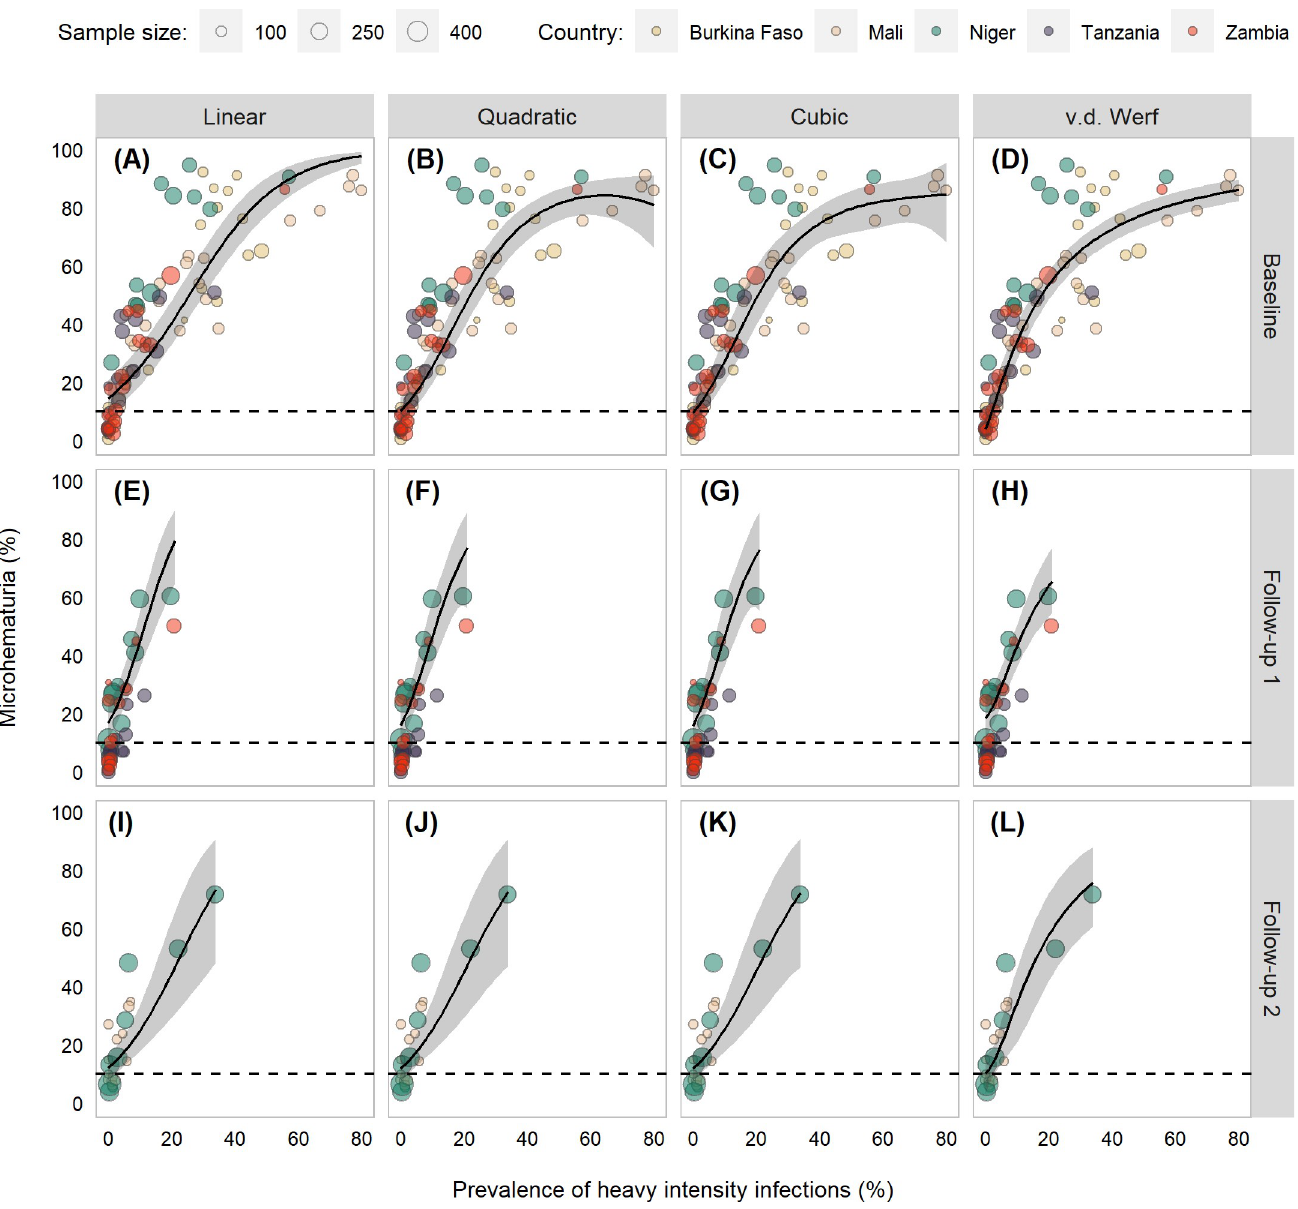
Fig 3. Scatter plots of Schistosoma haematobium prevalence of heavy intensity infections (PHI) and microhematuria prevalence of children aged 6–15 years from Burkina Faso, Mali, Niger, Tanzania, and Zambia participating in schistosomiasis control program activities between 2003 and 2008. Points are scaled based on the number of school-age children with S . haematobium infection data. Black line indicates model fits and gray shading indicates 95% Bayesian credible intervals (BCIs) from errors in variables model. The dashed line denotes 10% microhematuria